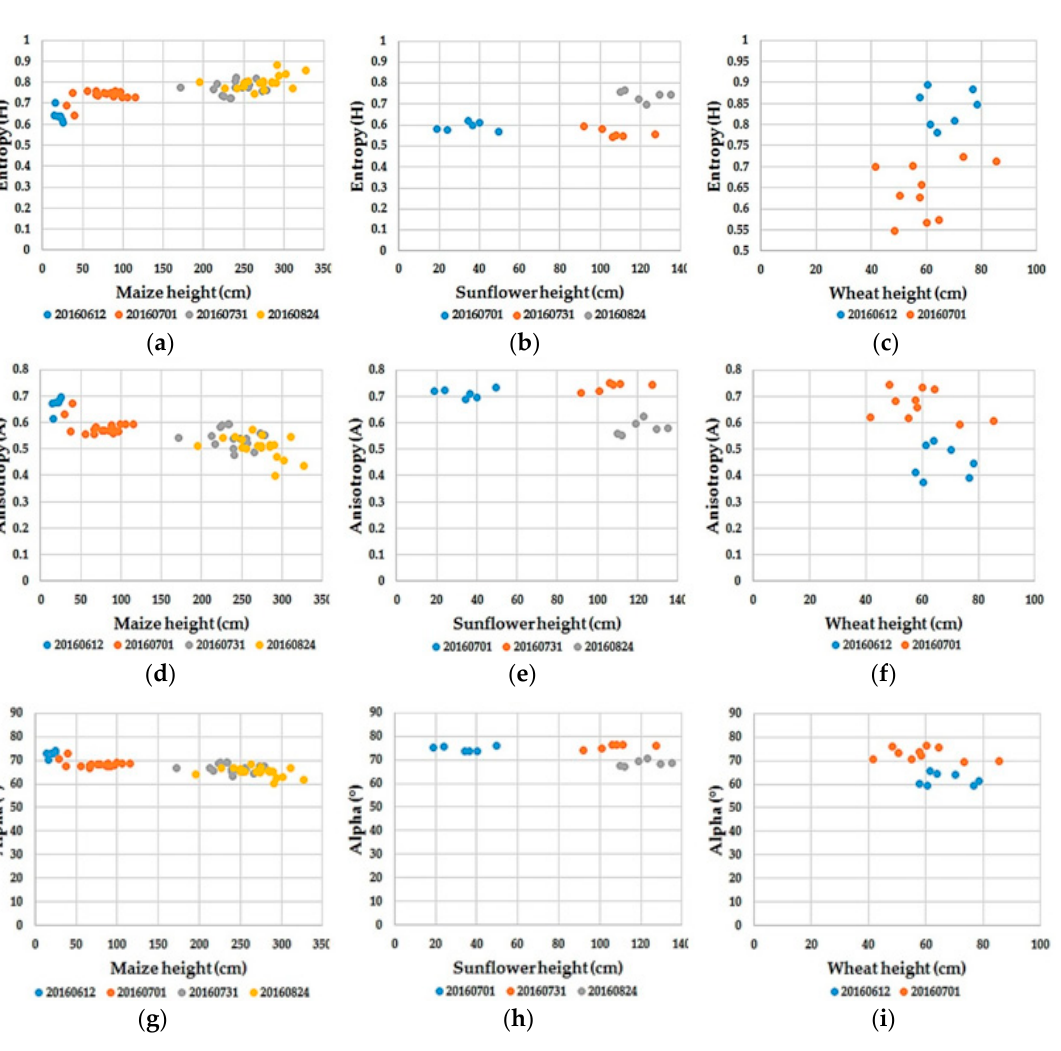
Figure 9. Correlation between Entropy ( a–c ), Anisotropy ( d–f ) and Alpha ( g–i ) decompositions of maize, sunflower and wheat with their height during growing stages.